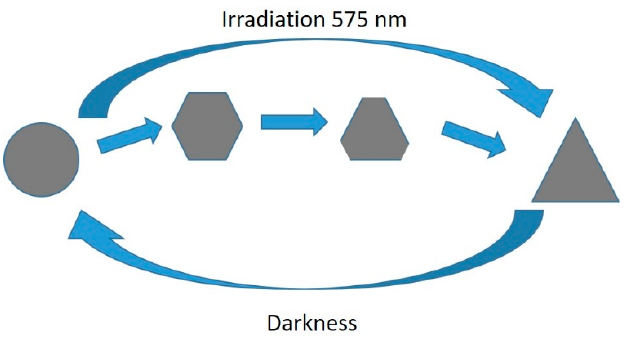
Figure 9. Interconvesion mechanism between round and triangular NPTs [49,50] .